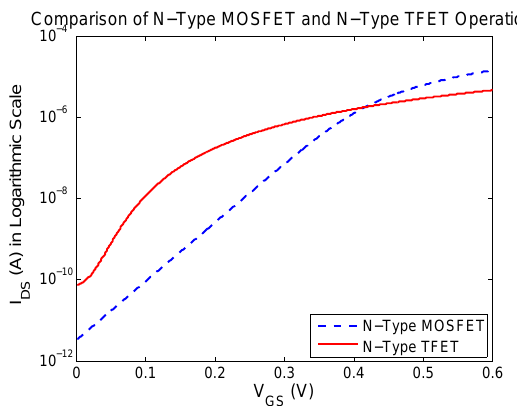
Figure 8. The comparison between the drain-source current versus gate-source voltage curves of the n-type metal–oxide–semiconductor field-effect transistor (MOSFET) and the n-type tunnel field-effect transistor